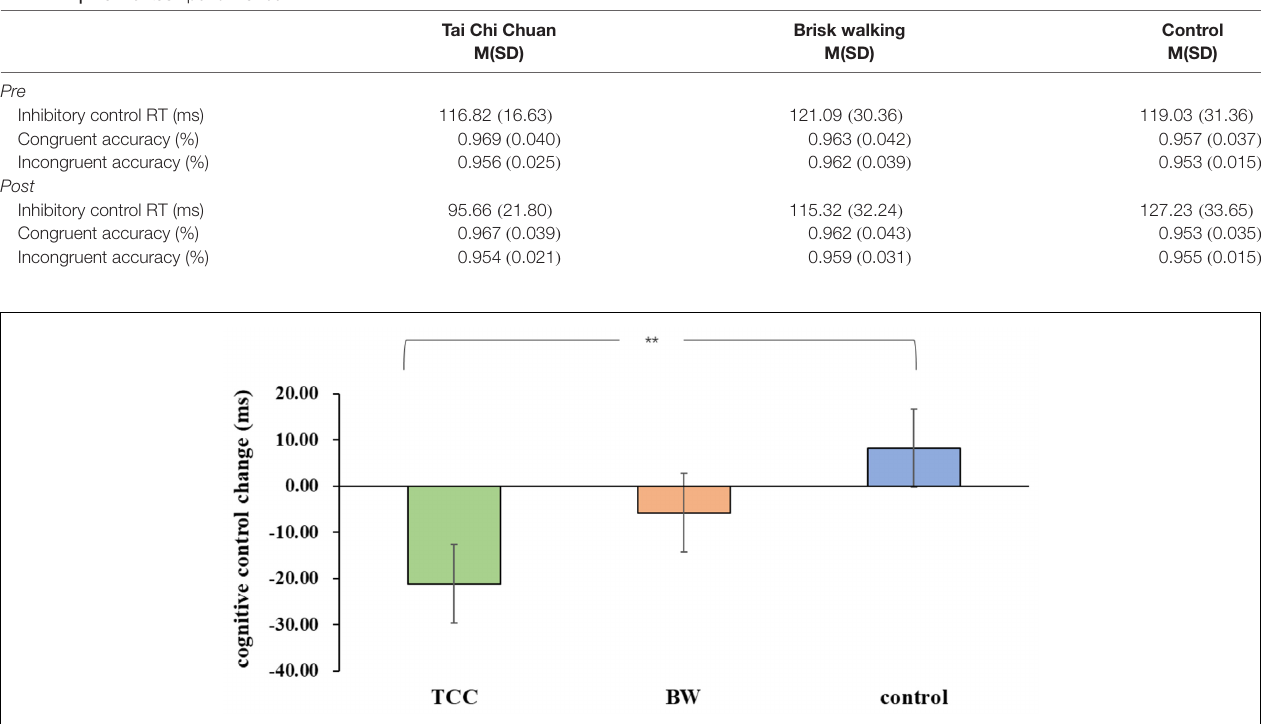
TABLE 2 | Flanker task performance.